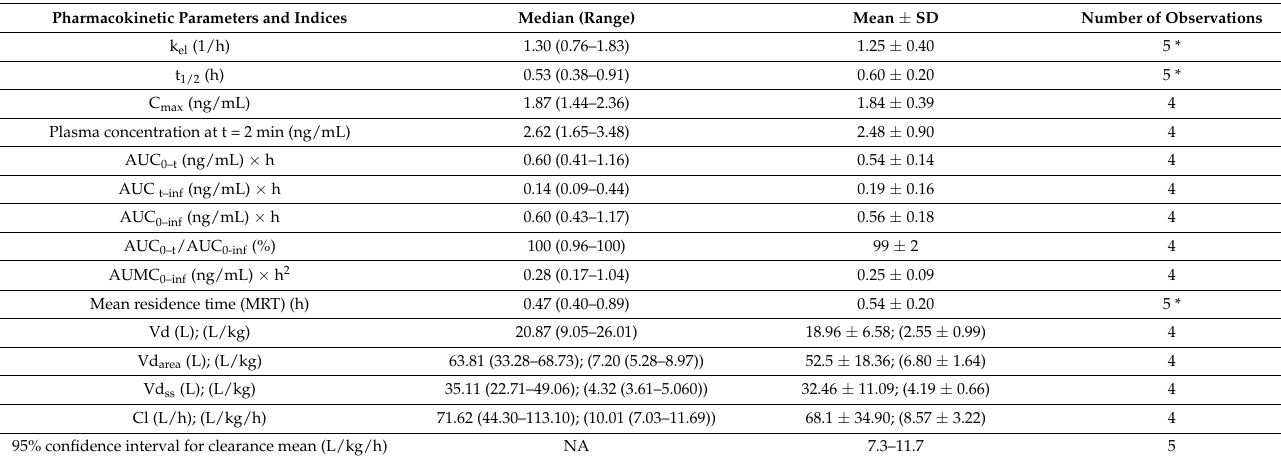
Table 1. Pharmacokinetic parameters and indices calculated from a non-compartment analysis following administration of a single i.v. 5 mg/kg bolus dose of